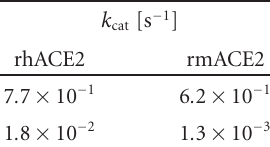
Table 1: Enzymatic properties of rhACE2 and rmACE2. The sub- strate turnover rates and product formation rates were determined for the kinetic experiments in Figure 2. Therefore, the slope of the linear regressions across all data points was determined for both substrate-product pairs and both enzymes. The mean of the absolute values for the substrate degradation rates and product formation rates for each enzyme were related to the molar concen- tration of rhACE2 or rmACE2. The resulting values for k cat are given in the table.